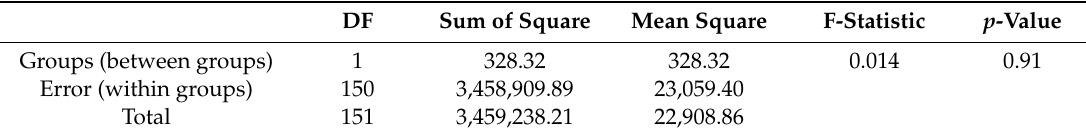
Table 8. Assumptions of normal distribution and homogeneity of variances.